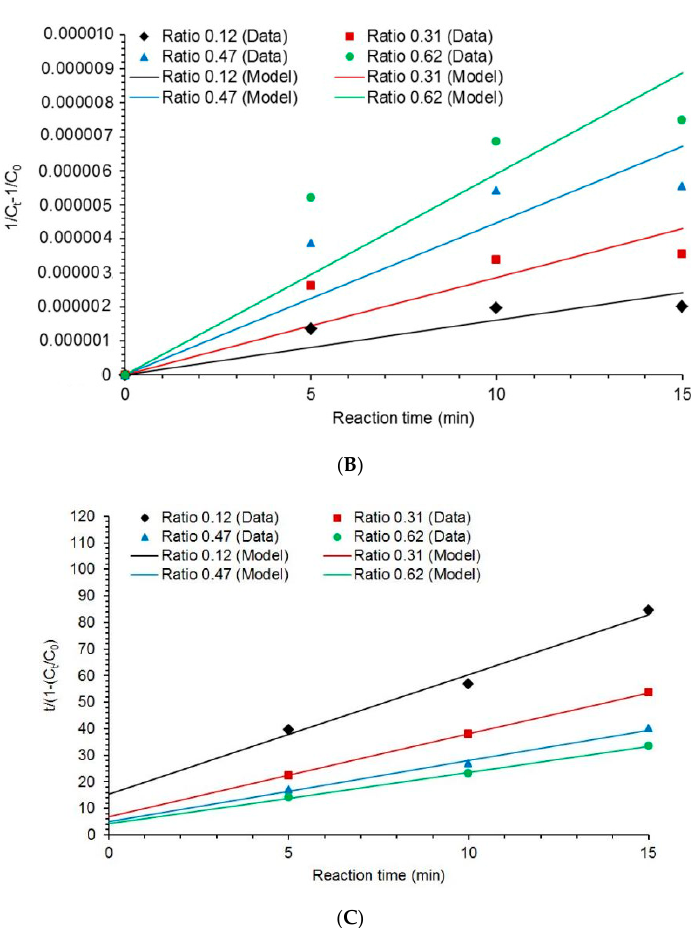
Figure 5. Kinetic models for COD degradation at different [H 2 O 2 ] to [COD] ratios: ( A ) first order, ( B ) second order, and ( C ) BMG.